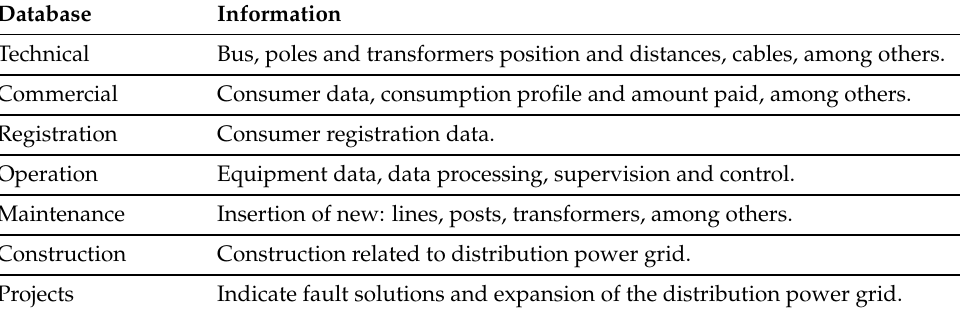
Table 2. Databases ×